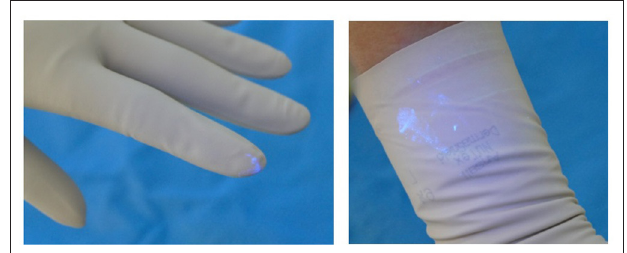
FIGURE 3 | Large “smear” of outer surface contamination.